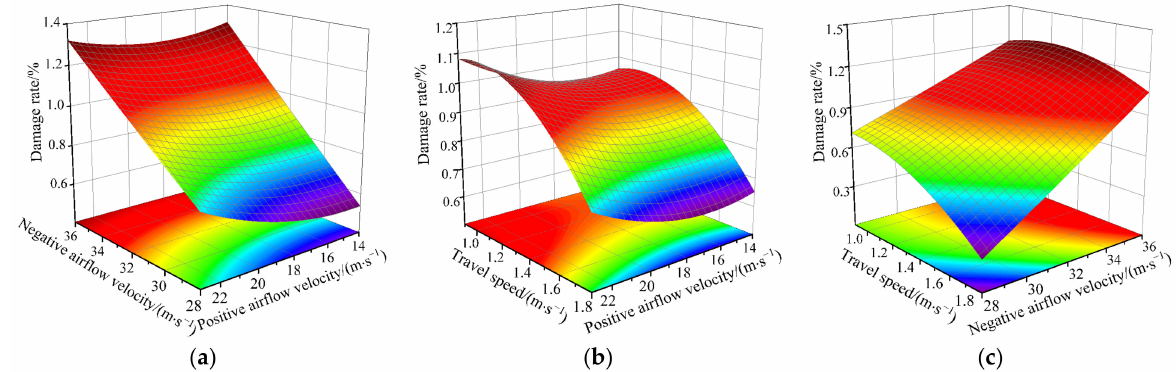
Figure 5. Response surfaces graph of the interaction factors for the damage rate: ( a ) influence of interaction factors between the positive airflow velocity and the negative airflow velocity, ( b ) influence of interaction factors between the positive airflow velocity and the travel speed, and ( c ) influence of interaction factors between the negative airflow velocity and the travel